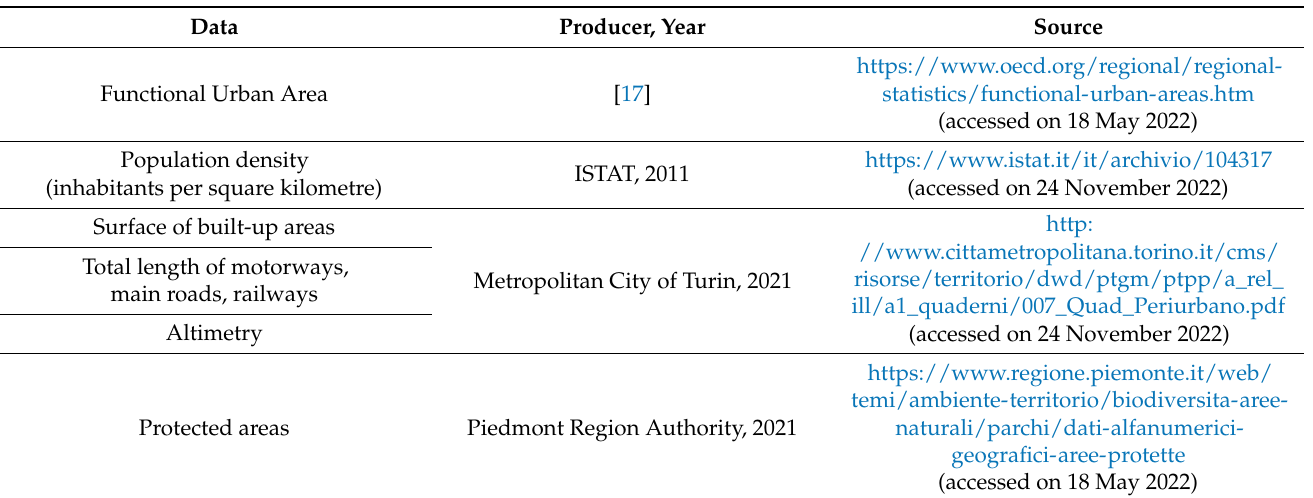
Table 2. Collected geospatial